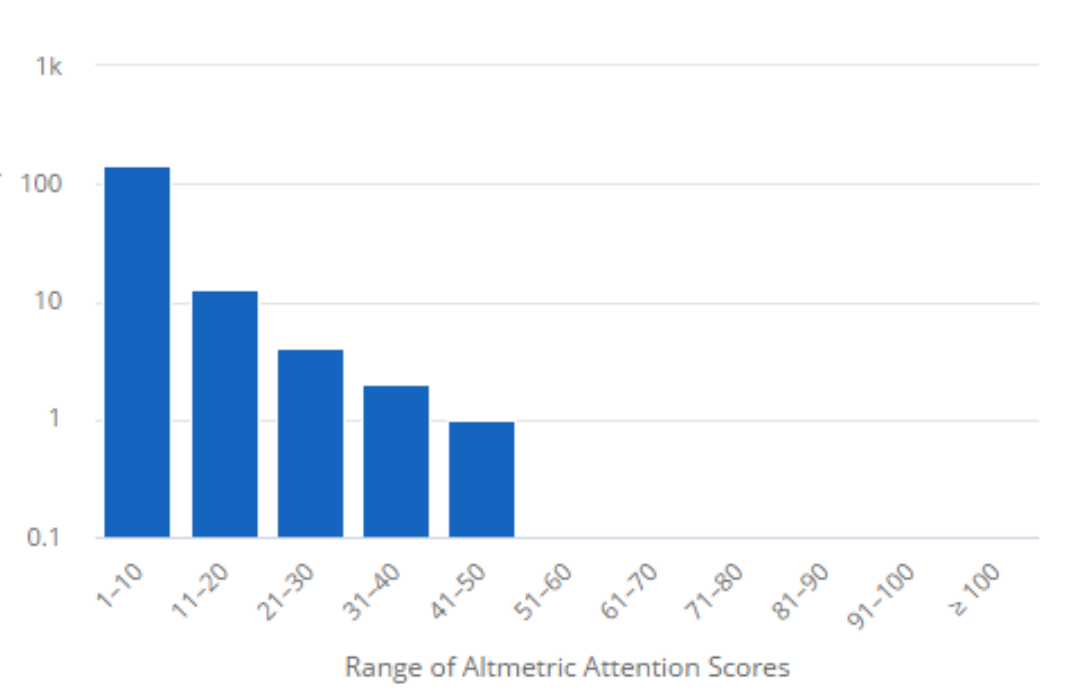
8 of 31 Figure 2. Trends of environmental valuation publications between 1987 and 2021.